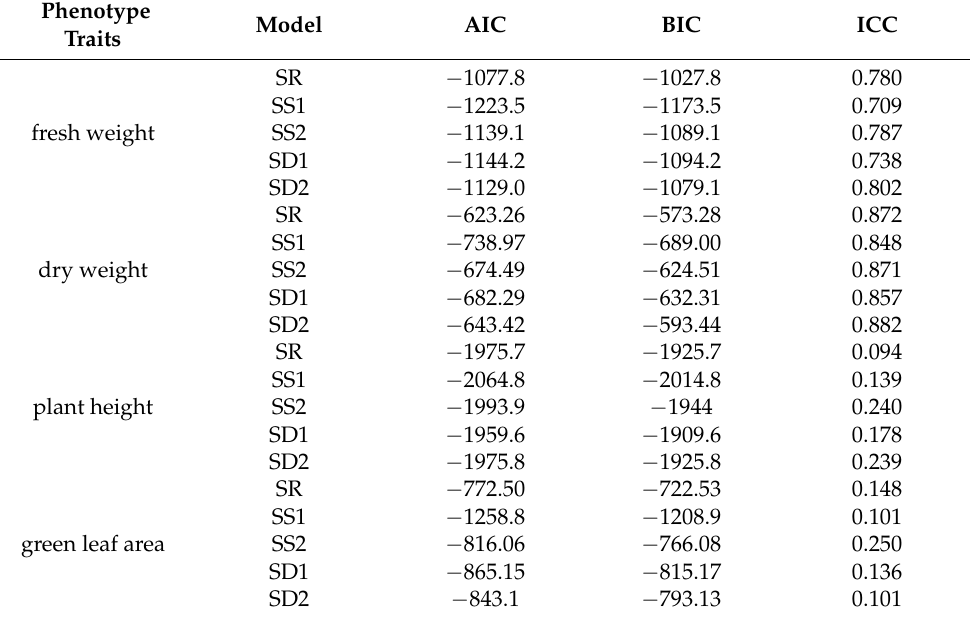
Table 3. The fitting result of the mixed linear